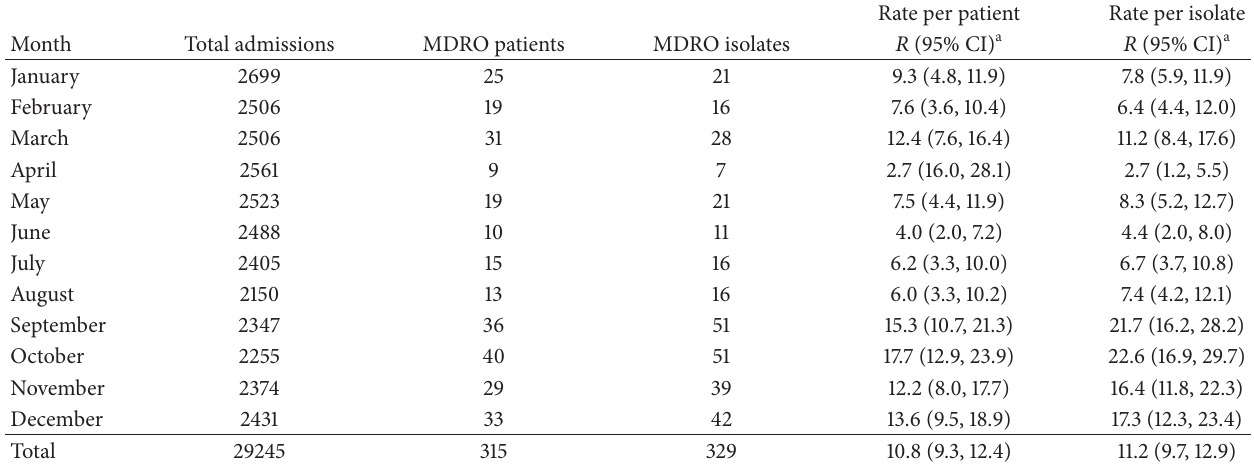
Table 1: Cumulative frequencies and rates of hospital-acquired multidrug resistant organisms (MDRO) among patients and isolates at SQUH, Oman, 2012.